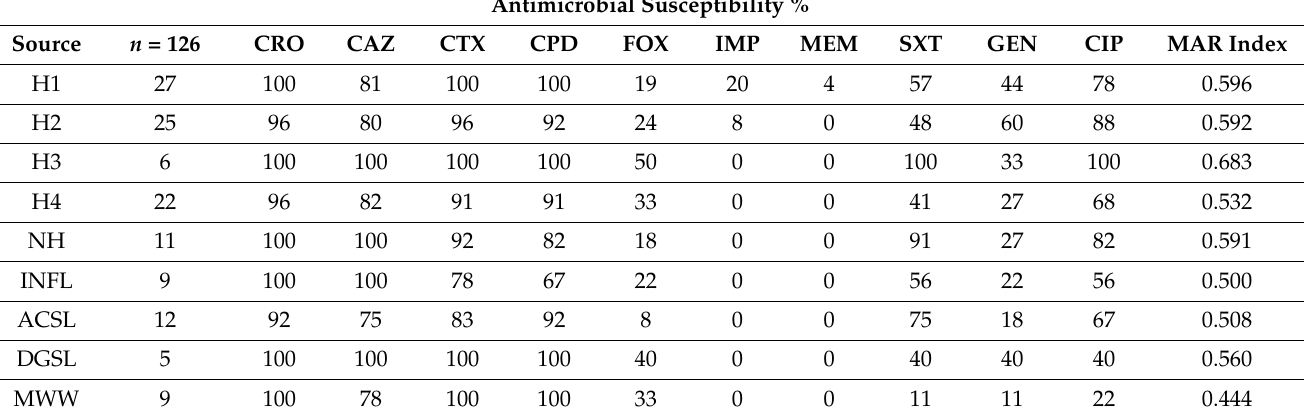
Table 2. The antimicrobial susceptibility of enteric bacteria in percentage in the samples from the various sites.